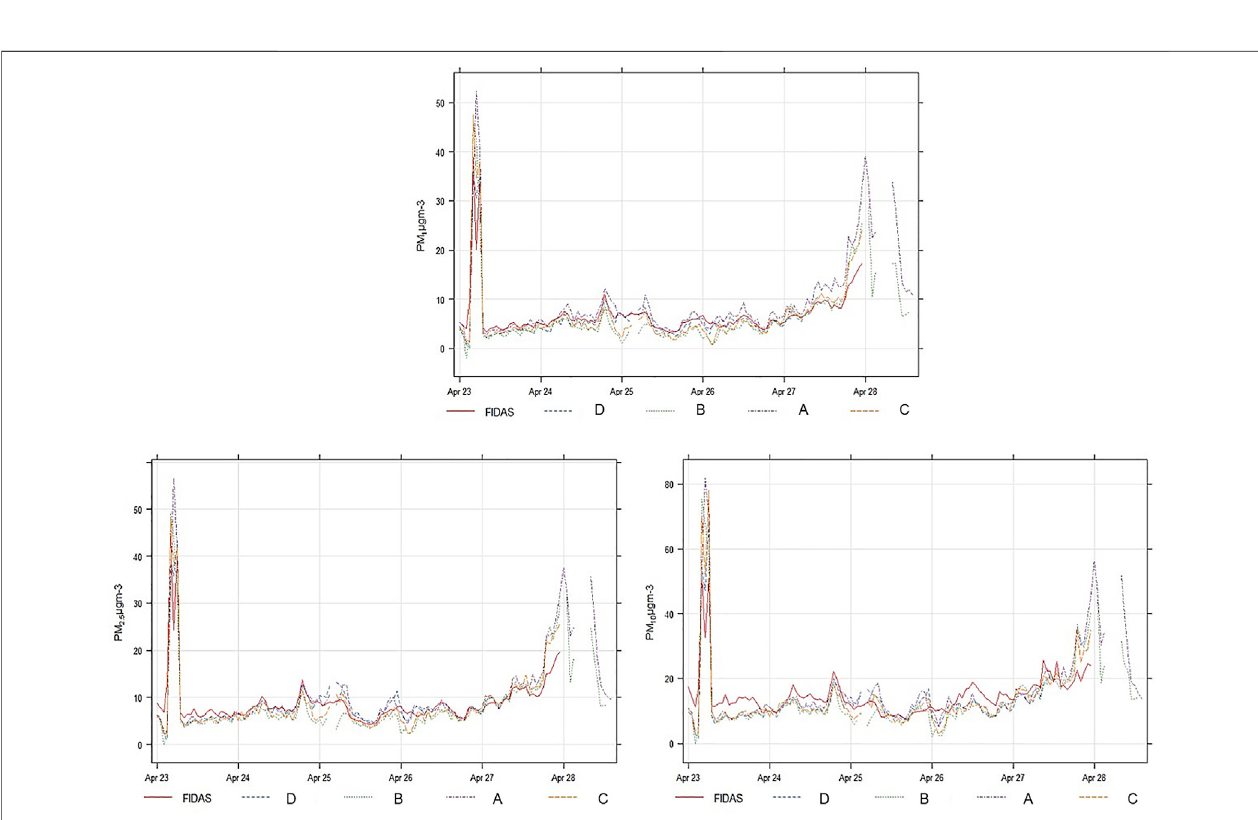
FIGURE 9 | Time plots of hourly averaged PM concentrations for Altasense PM and FIDAS after correction using the multi-linear approach that differentiates correction by humidity.